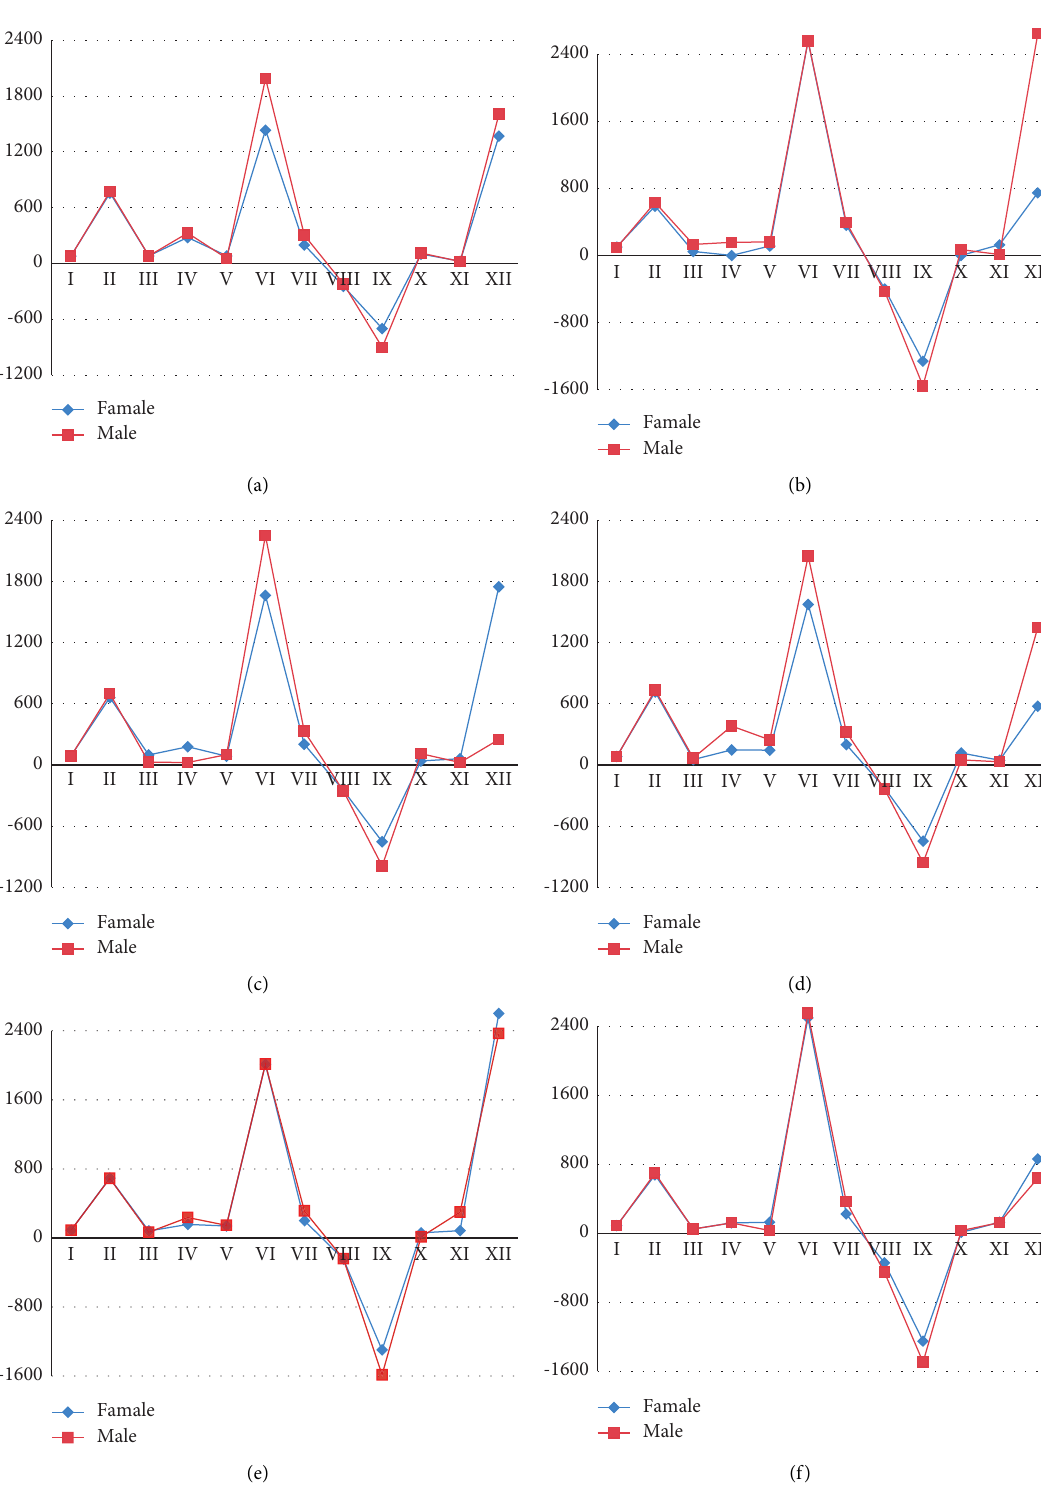
Figure 12: Male and female drivers’ ECG characteristics in anxiety. (a) 45–50 years old ∗ novice ∗ extraversion. (b) 45–50 years old ∗ novice ∗ middle type. (c) 45–50 years old ∗ novice ∗ introversion (d) 22–27 years old ∗ novice ∗ extraversion. (e) 22–27 years old ∗ novice ∗ middle type. (f) 22–27 years old ∗ novice ∗ introversion (I, AVHR; II, AVNN; III, SDNN; IV, PNN 50 ; V, RMSSD; VI, RWAVE; VII, TWAVE;